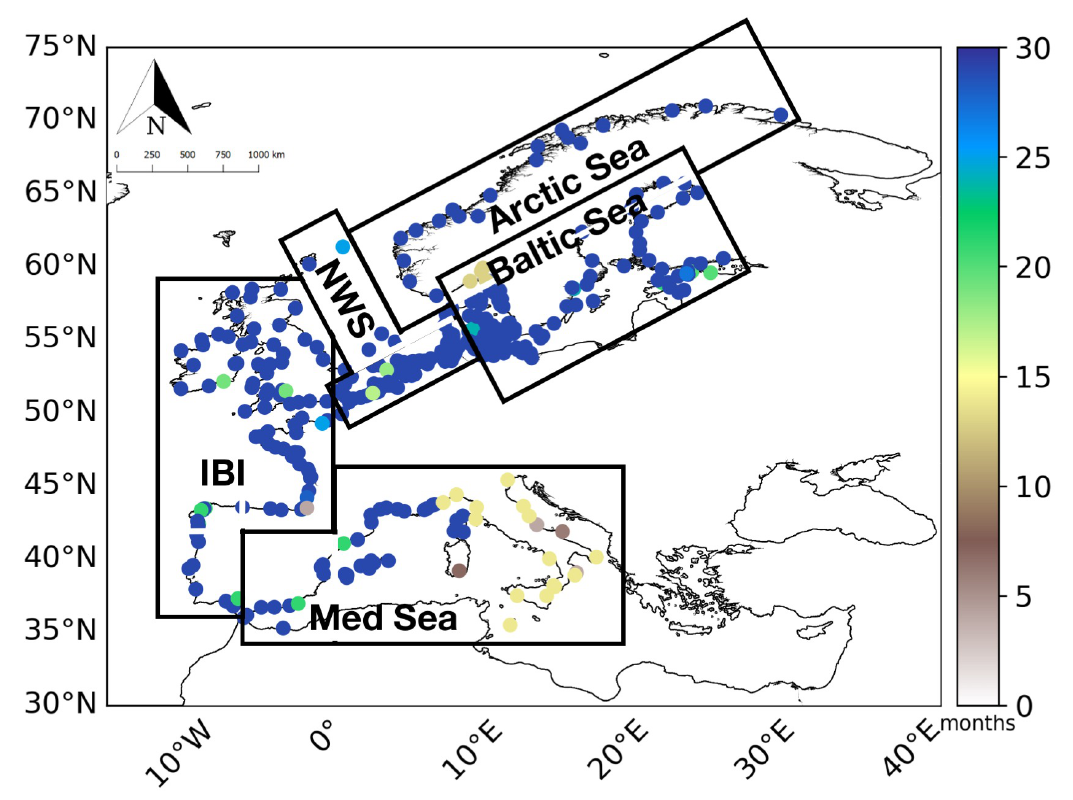
Figure 2. Location of the 370 tide gauges of the global product in the Copernicus catalogue along the European coasts and the western Mediterranean Sea used to compare with altimetry data after applying the selection criteria described in the text. Colours indicate the length of the time series of the concurrent tide gauge data and altimeter data. The black squares denote the sub-regions used for the inter-comparisons (see the text for